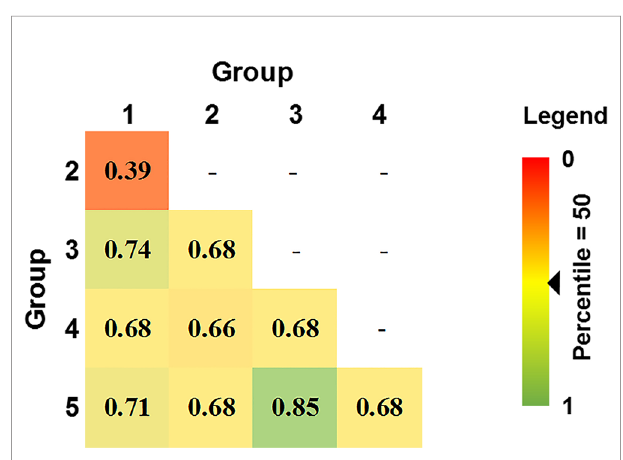
FIGURE 4 | Pair-wise genetic distances between fi ve DAPC Australian P. nodorum groups using Prevosti's distance. Genetic distances are ranked by percentile score. 0 and 1 denotes 0 and 100 th percentile,